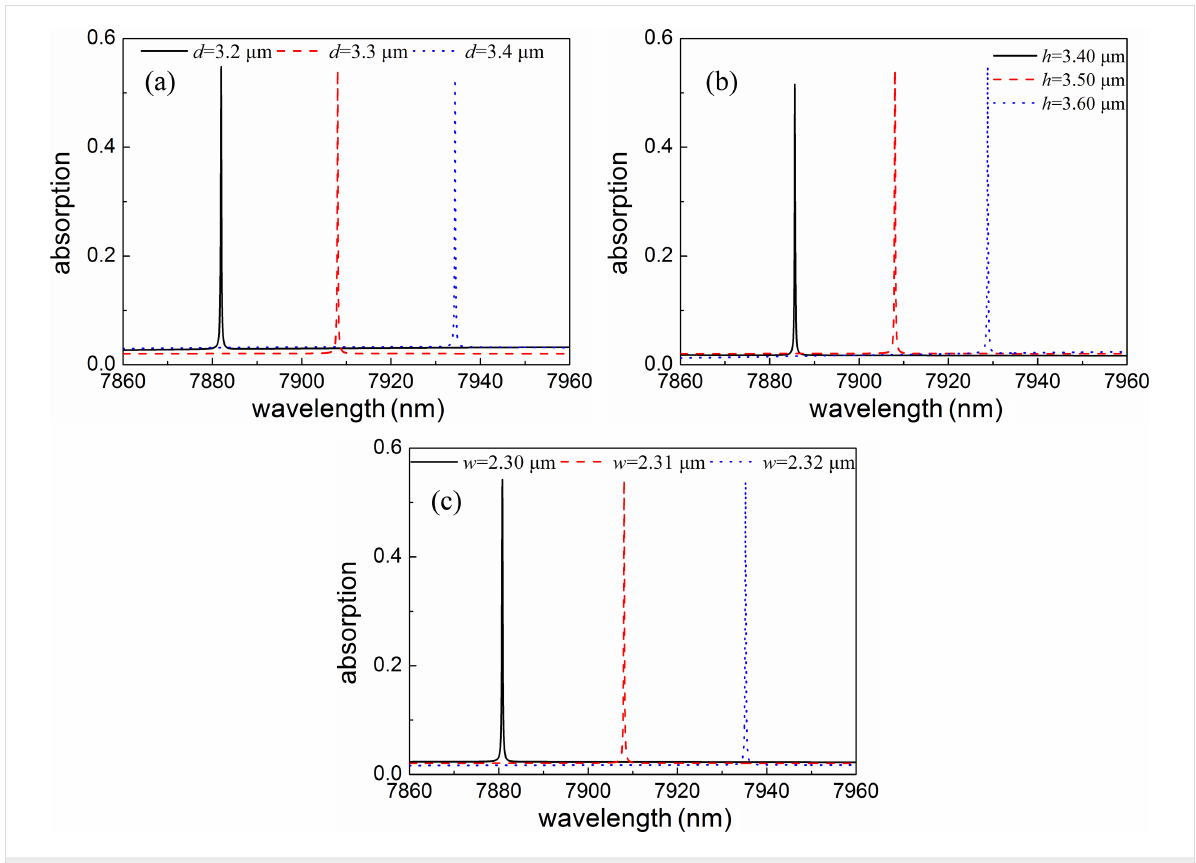
Figure 6: Absorption spectra of the graphene absorbers for different values of (a) d , (b) h and (c) w .